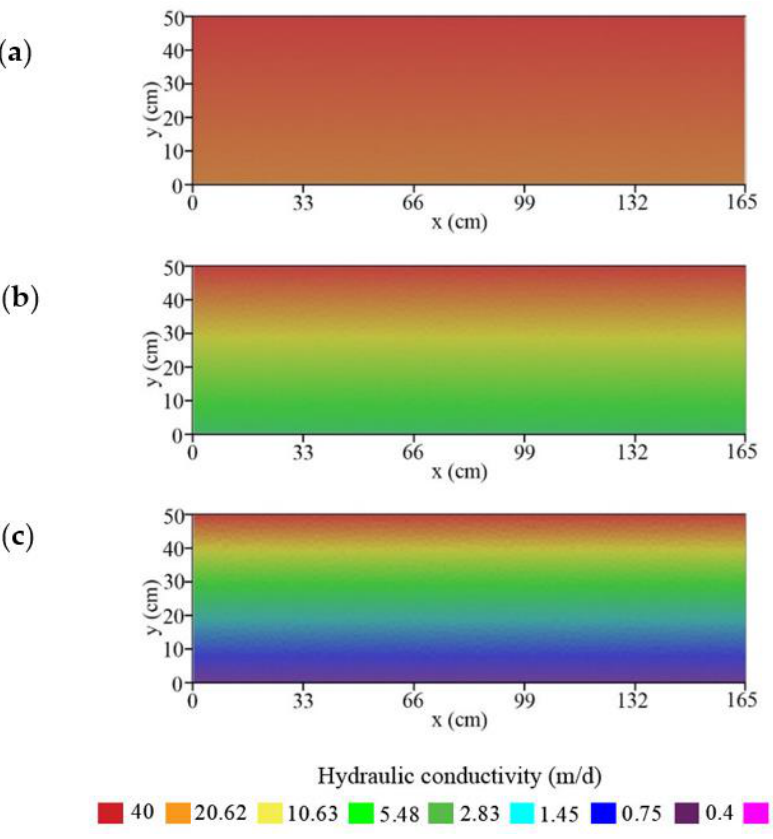
Figure 3. Hydraulic conductivity fields with different depth-decay exponents. ( a ) the decay exponent was set to 0.01 m −1 , ( b ) the decay exponent was set to 0.05 m −1 , ( c ) the decay exponent was set to 0.1 m −1 .